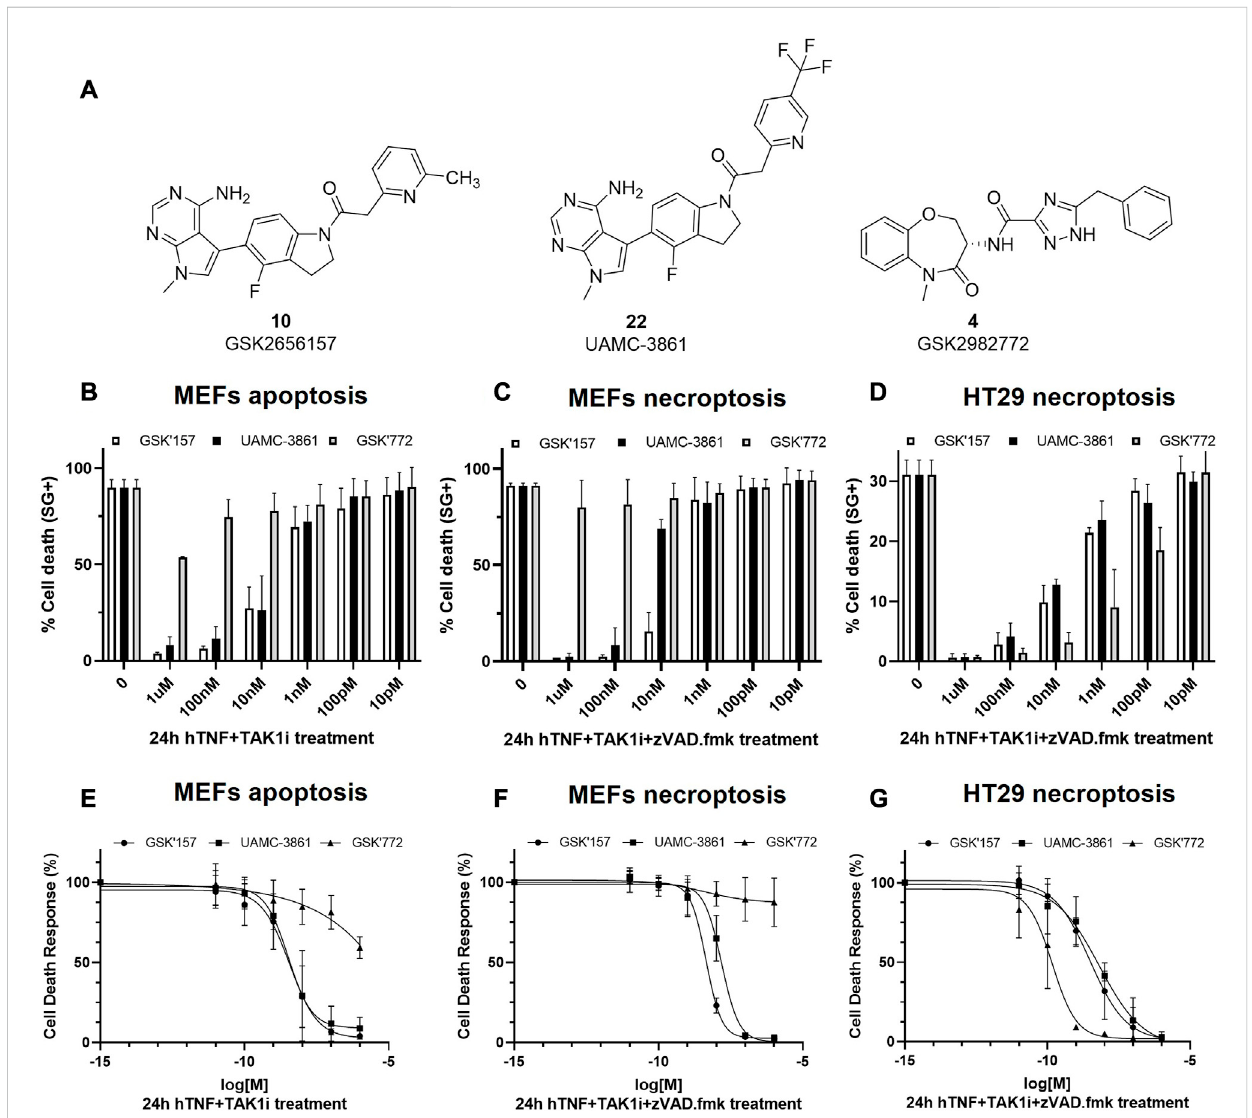
FIGURE 7 RIPK1-dependent cell death inhibition in mouse and human cells for GSK ’ 157, UAMC-3861 and GSK ’ 772. (A) Chemical structures of the compounds that were tested in vitro for RIPK1-dependent apoptosis and necroptosis. (B , C) MEFs and (D) HT-29 were pre-treated for 30 min with increasing concentrationsoftheindicatedcompounds.RIPK1kinase-dependentapoptosiswasinducedbyTAK1i+hTNF(100 pg/mL)andRIPK1kinase-dependent necroptosis by zVAD.fmk + TAK1i + hTNF (100 pg/mL) and hTNF + zVAD.fmk (20 ng/mL). Cell death was measured over time by Sytox Green positivity(SG+)andtheresultsarepresentedasmean±SEMofthreeindependentexperiments. (E – G) MEFsandHT-29werepre-treatedfor30 minwith increasing concentrations of the indicated compounds. In presence or absence of TAK1i (1 µM) and/or